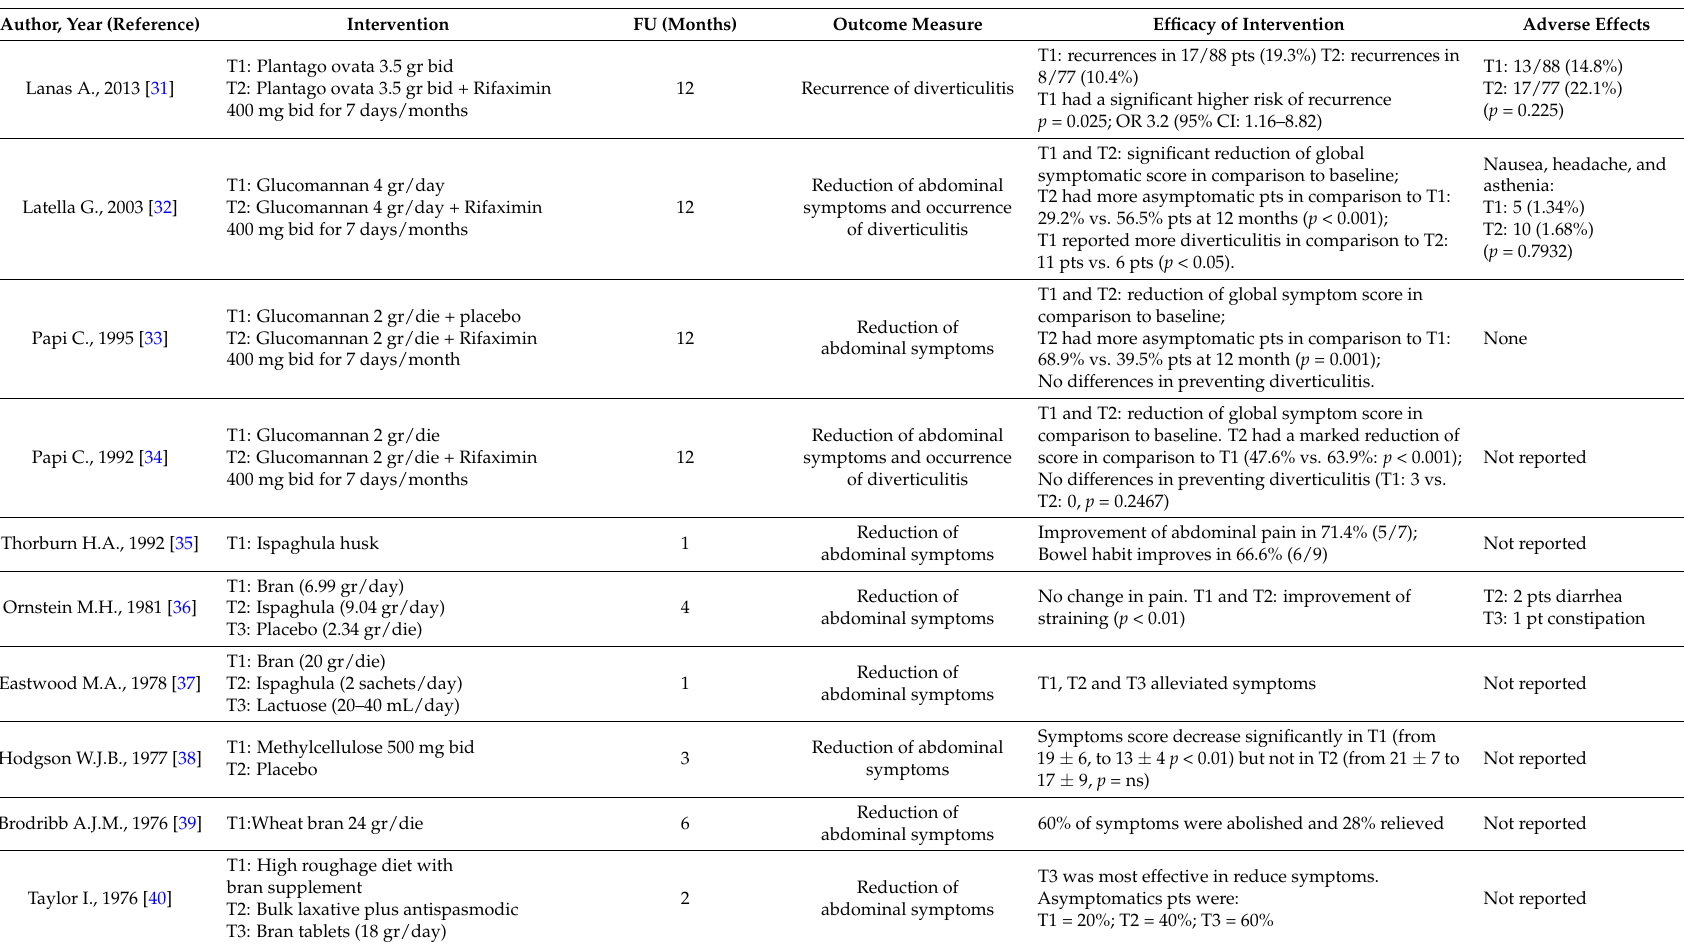
Table 4. Intervention and follow-up protocol in the selected studies of supplemental fiber treatment in symptomatic uncomplicated diverticular disease